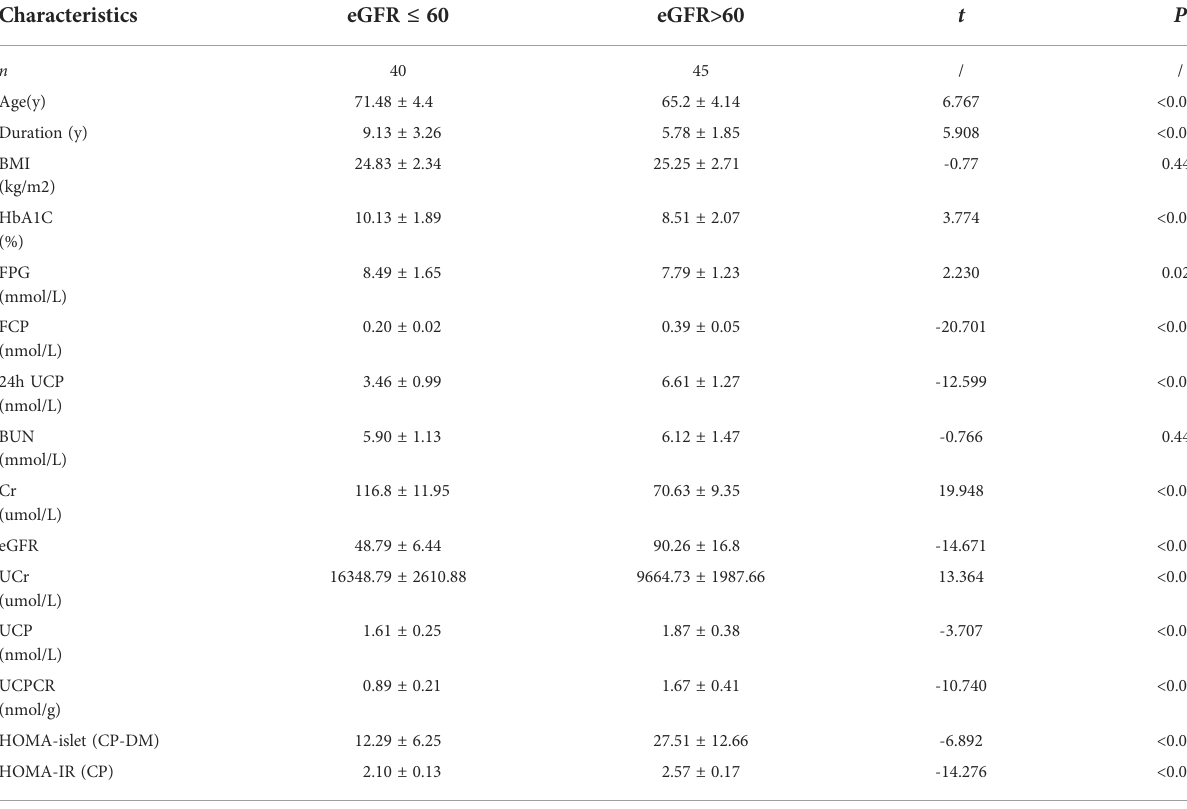
TABLE 1 Comparison of clinical parameters between the two groups of